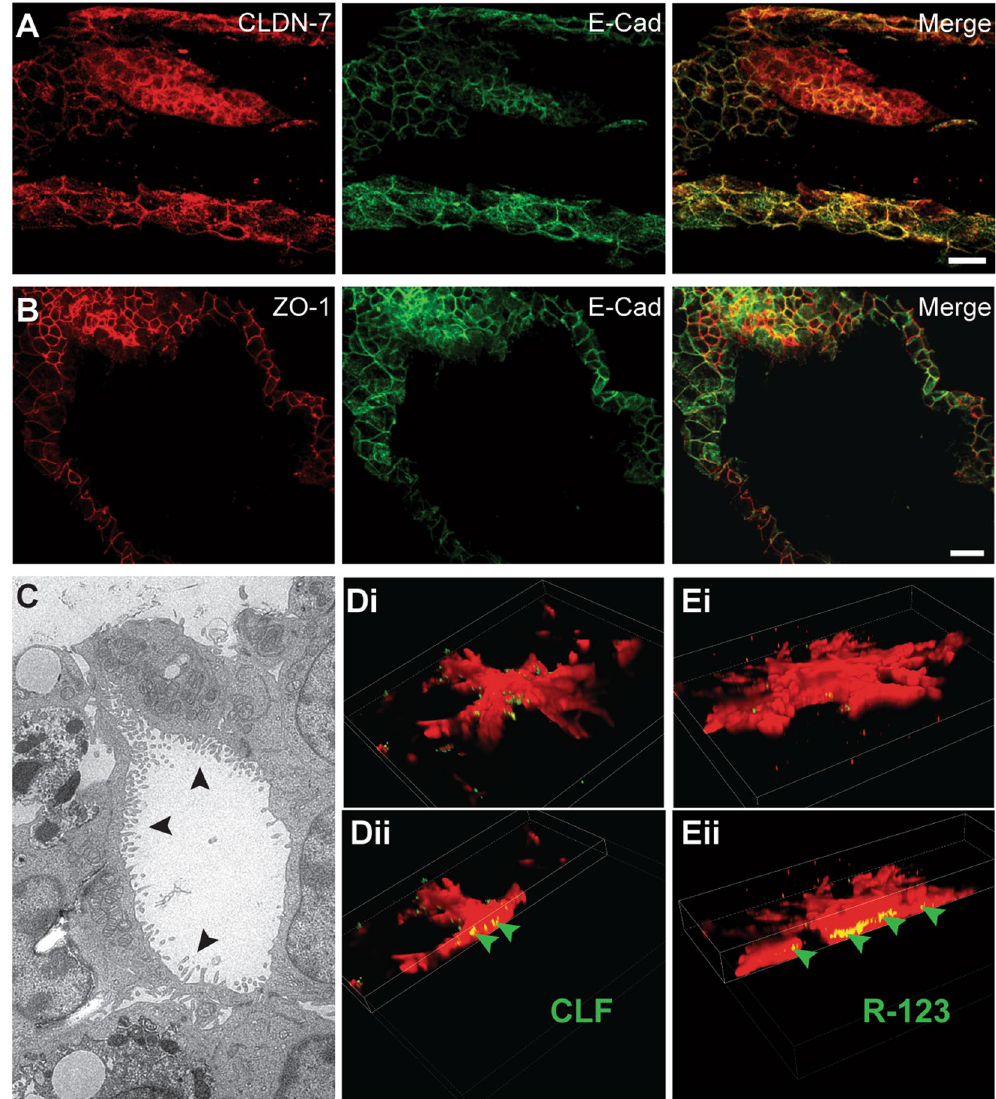
Figure 5. Duct-Like Structures Show Functional Maturation. ( A,B ) E-Cadherin, Claudin-7, and Zonula Occludens-1 (ZO1), are all expressed in duct-like structures, indicating maturation of tight junctions. ( C ) Apical microvilli (arrows) are visible under TEM in cross-sections of duct/cyst lumen. ( D,E ) mCherry- expressing SV40SM structures incubated in either CLF (Di) or R123 (Ei). Cutaways (Dii, Eii) indicate apical secretion (arrowheads) of the dye into an interior lumen, which appears yellow due to red/green overlap. Scale bars = 25 μ